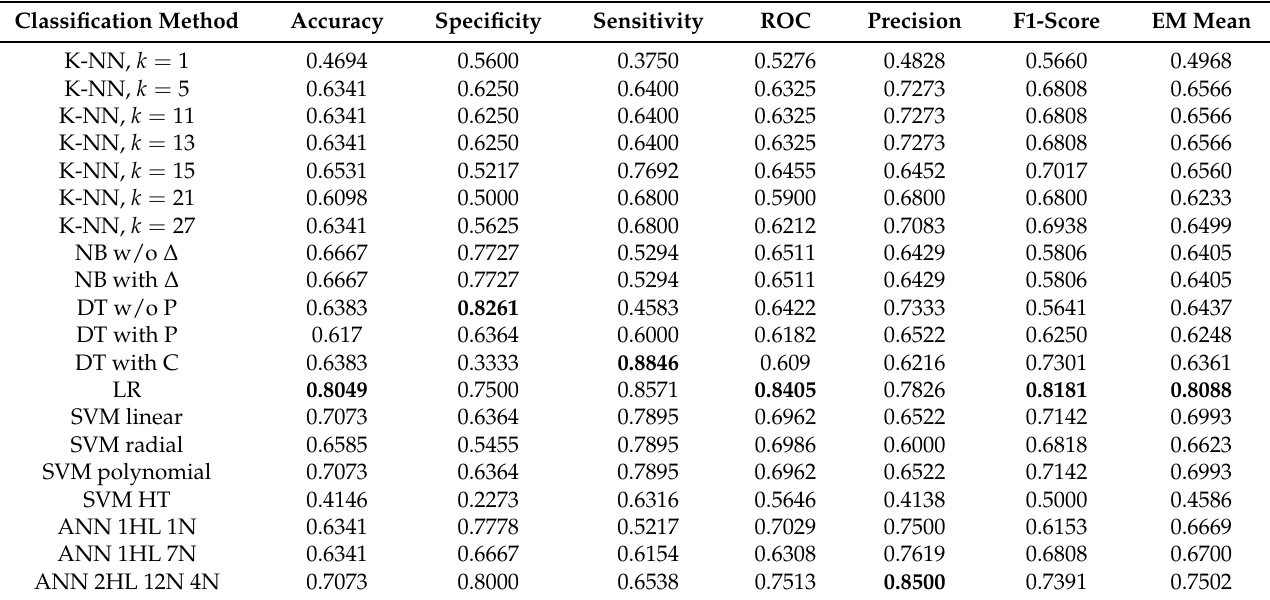
Table 3. Evaluation metrics for each classifier of the standardized